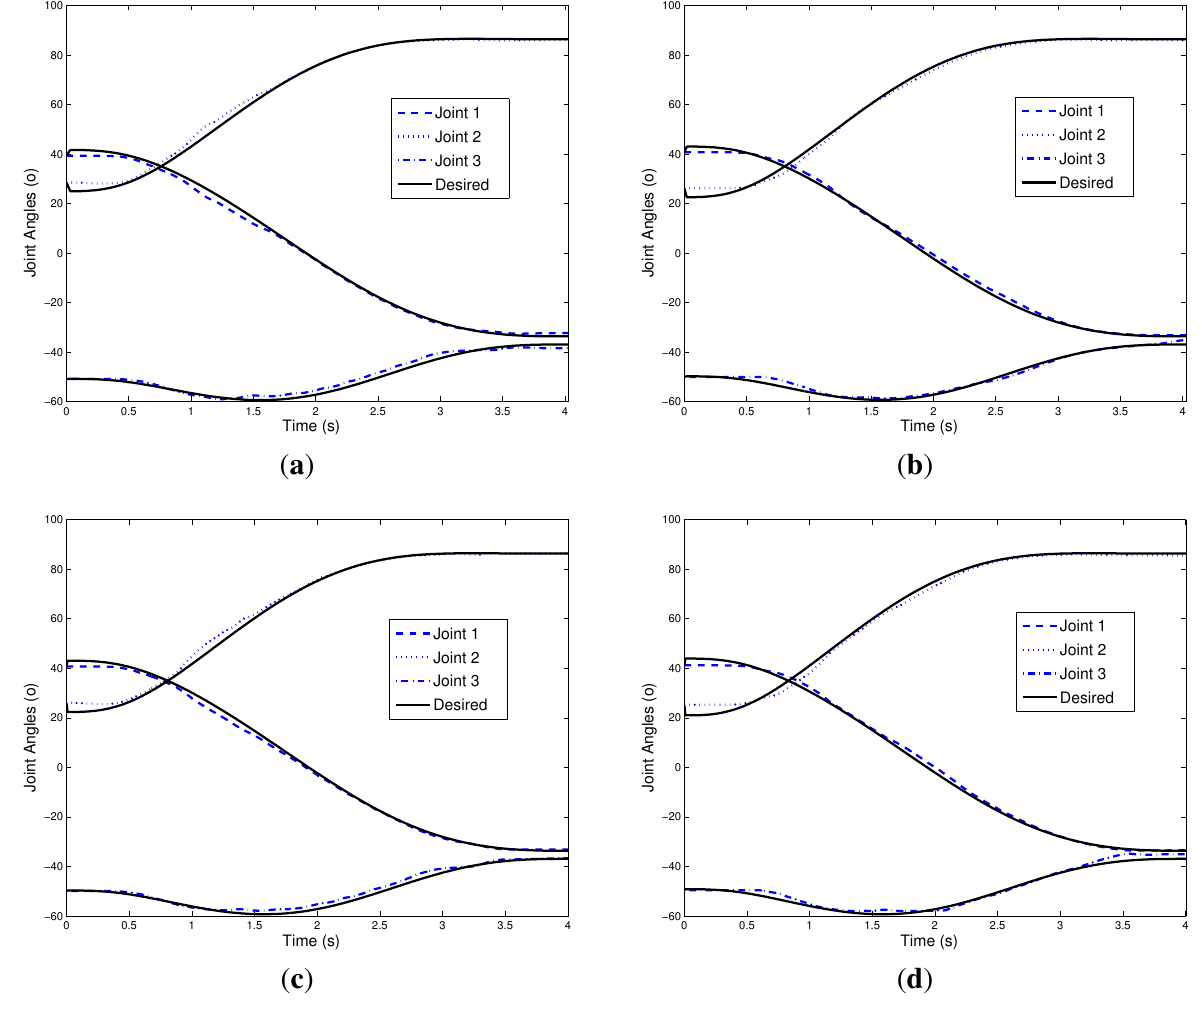
Figure 12. Joint Angles. ( a ) NN1; ( b ) NN2; ( c ) FS1; ( d ) FS2; ( e )